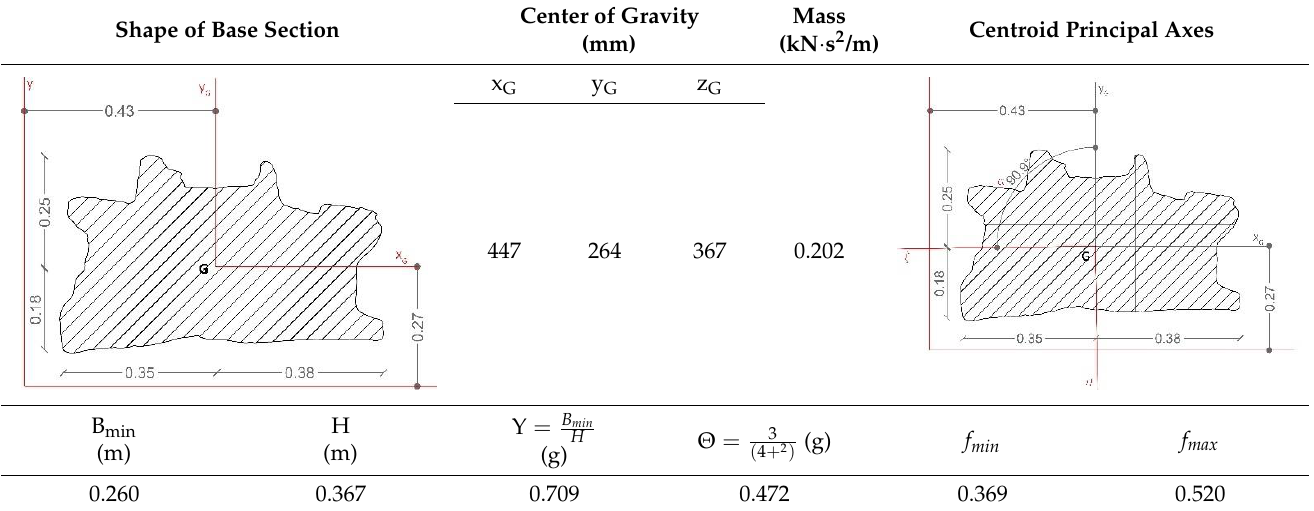
Figure 11. Modal analysis of Mater Matuta : first (left— f 1 = 122.2 Hz) and second (left— f 2 = 183.6 Hz) mode; displacement mapping color code ranges between blue (still points) to red (maximum modal displacements). Table 4. Summary of the main geometric features of the asset for seismic rigid block analyses. Shape of Base Section